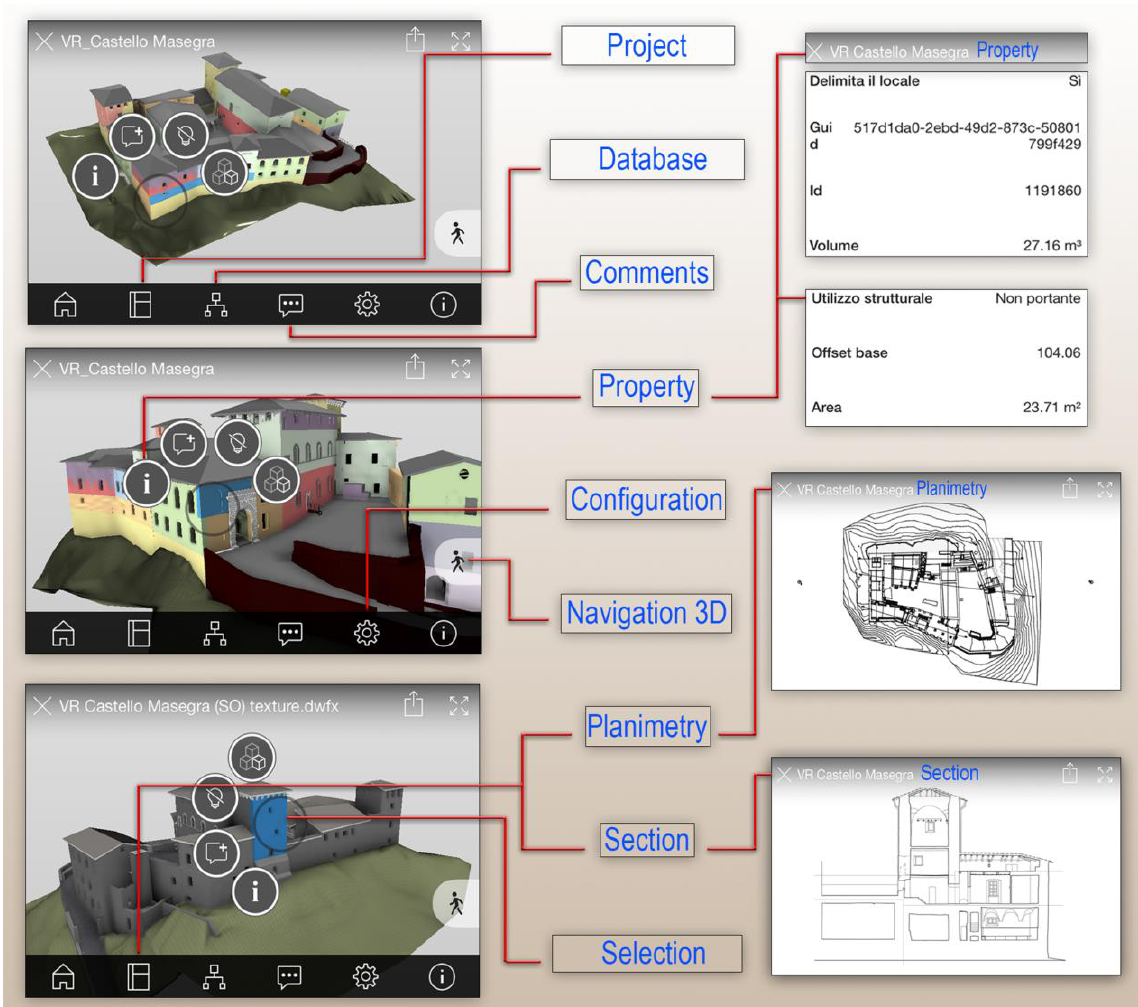
Fig. 12. The use of the HBIM with an iPad: interactive visualization and queries can be easily carried